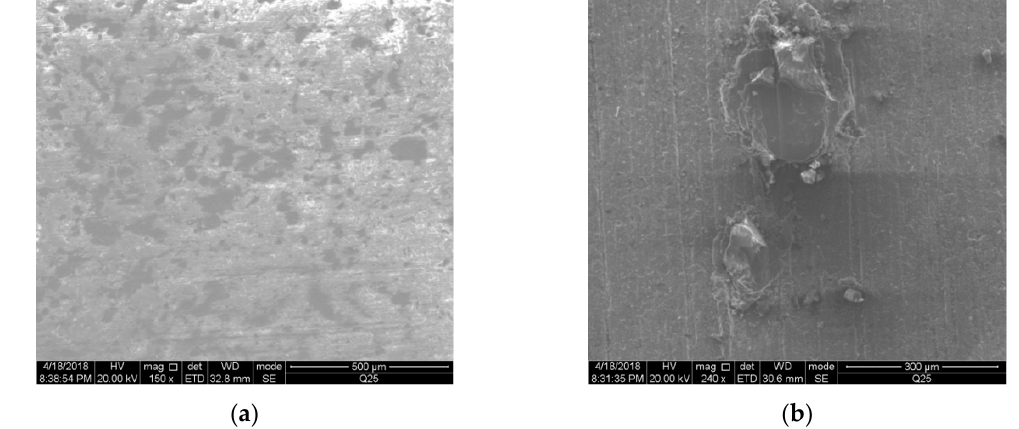
Figure 15. Power consumption of the scroll compressor coated with DLC film. Figure 16. The suction end surface topography of the orbiting scroll after the compressor with DLC film is running: ( a ) 150 times; ( b ) 240 times.